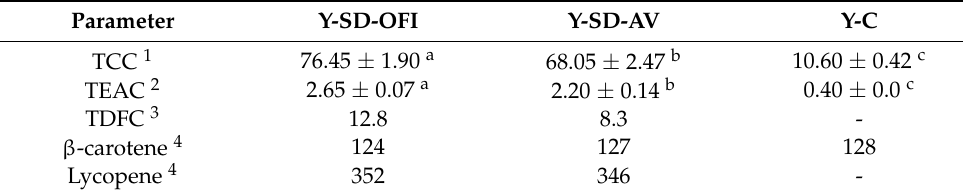
Table 1. Total carotenoid content (TCC), antioxidant capacity (TEAC), and total dietary fiber content (TDFC), as well as β -carotene and lycopene quantification via HPLC–MS, for yogurt samples enriched with pulp-guava/mucilage microcapsules (Y-SD-OFI and Y-SD-AV) versus yogurt containing E110 dye (Y-C). Different superscript letters in the same row and column for each parameter indicate a statistical difference ( p < 0.05) between samples.